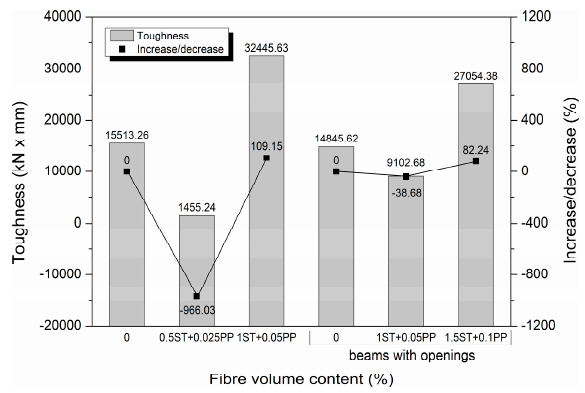
Figure 9. Comparison of beam toughness.